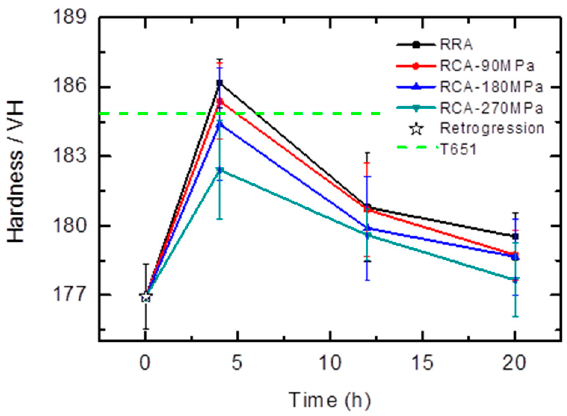
Figure 7. Hardness of the studied aluminum alloy during various aging treatments at 140 °C .